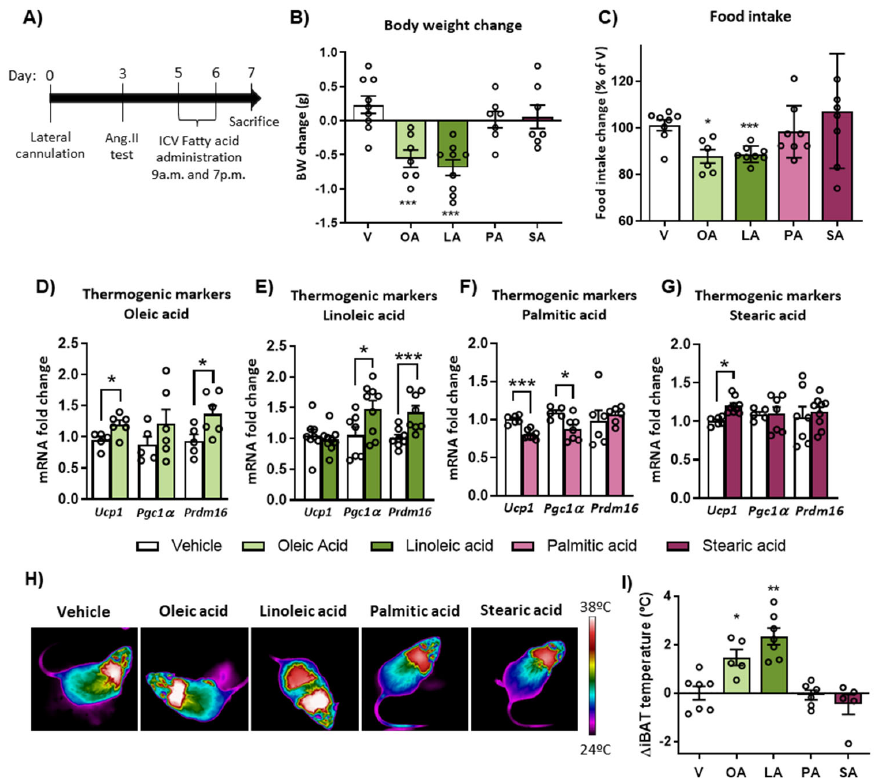
Figure 2. Effects of intracerebroventricular (ICV) administration of oleic acid, linoleic acid, palmitic